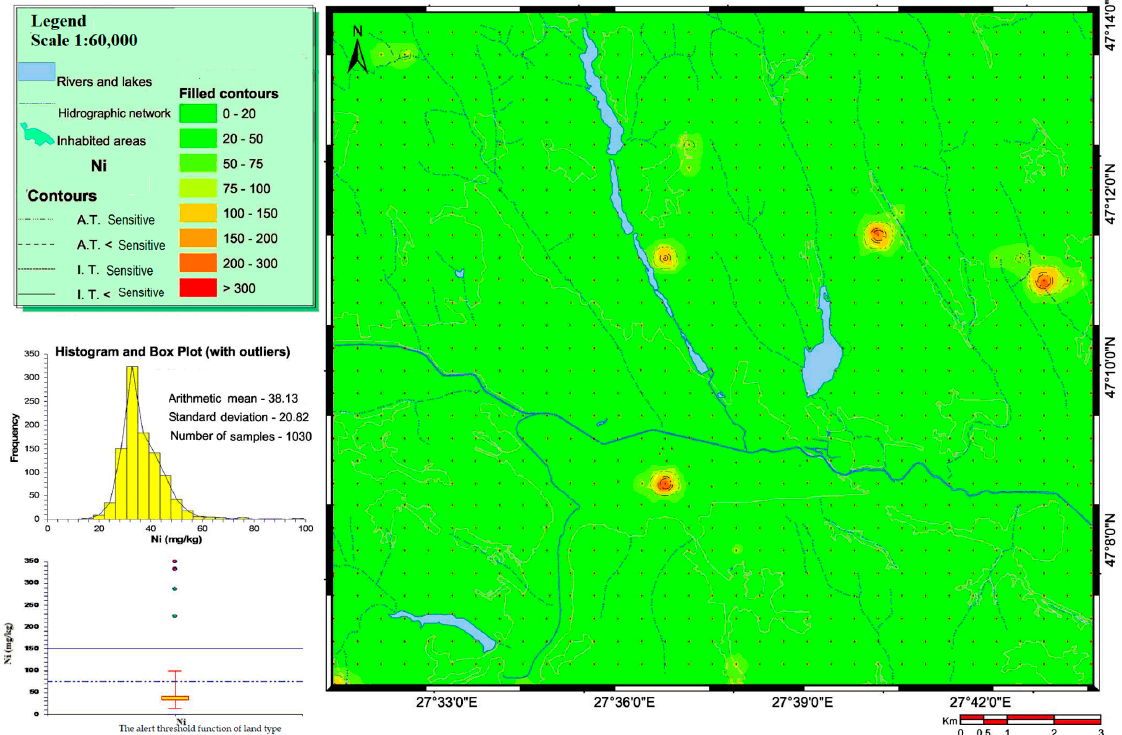
Figure 4. Map of Ni distribution in the analysed soil (mg kg − 1 ) .